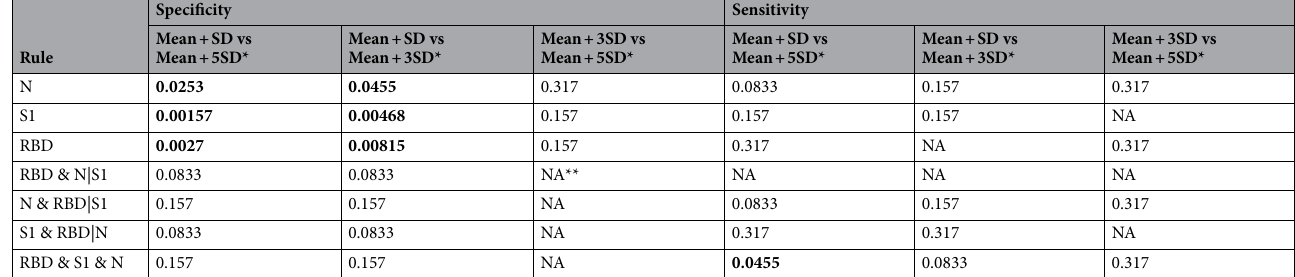
Table 4. p-values of the McNemar’s test to compare the performance of each rule across different cut-off values for total antibody detection. p-values lower than the 0.05 threshold are highlighted in bold. *Mean and